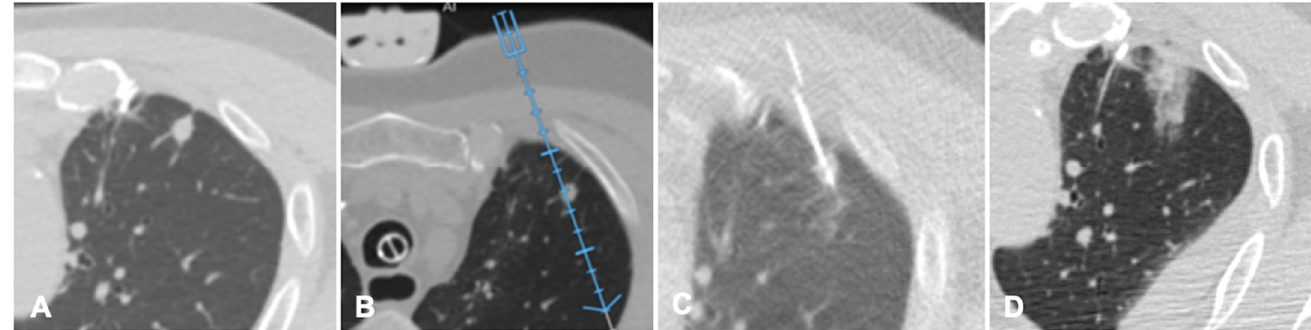
Figure 4. Case of an oligometastatic colonic adenocarcinoma in a patient with a nodule in the upper lobe of the left lung treated with microwave ablation (MWA). ( A ) Axial view of the preoperative Computed Tomography (CT) scan confirms the presence of a 4 mm nodule in the left upper lobe adjacent to the pleural profile. ( B ) Using electromagnetic virtual navigation guidance, the skin entry point is selected and the MWA antenna is inserted. ( C ) Multiplanar reconstruction of intraoperative CT scan along the needle long axis showing correct targeting of the lesion. ( D ) Control CT at the end of MWA treatment showing complete ablation without complications.